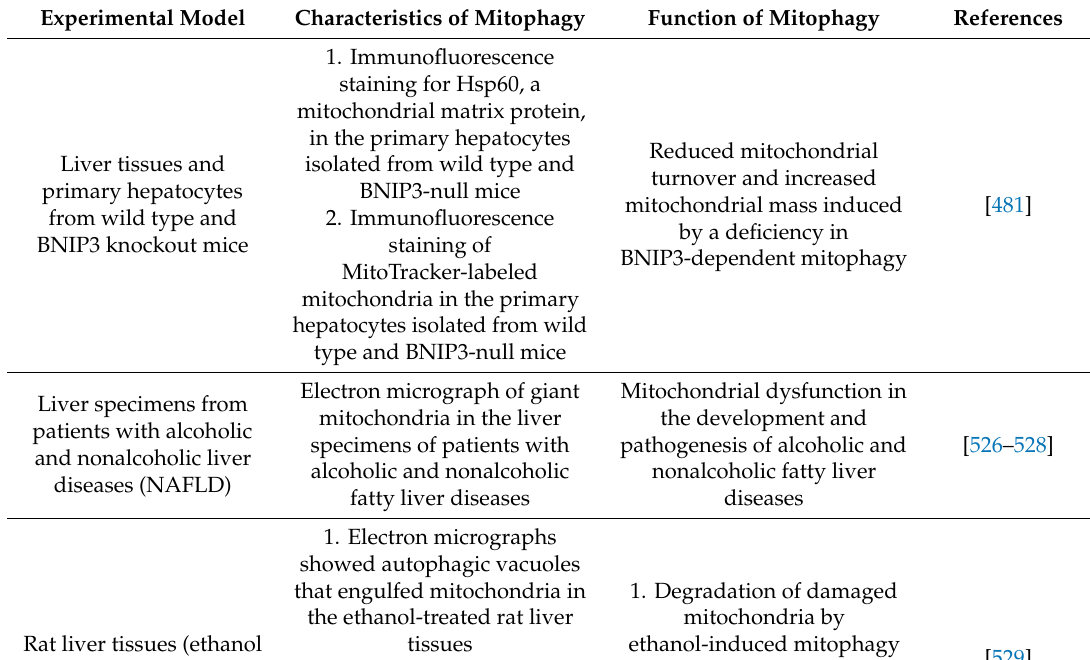
Table 3. Summary of the roles of mitophagy in steatosis and fatty liver diseases. Experimental